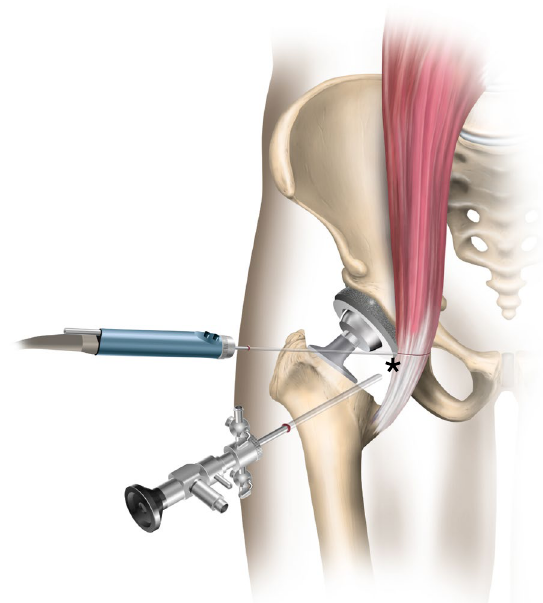
Fig. 1 Total hip arthroplasty, anteroposterior radiograph. Postoperative radiograph after a total hip arthroplasty. Notice the cement extrusion at the acetabular side that caused the mechanical irritation of the psoas tendon